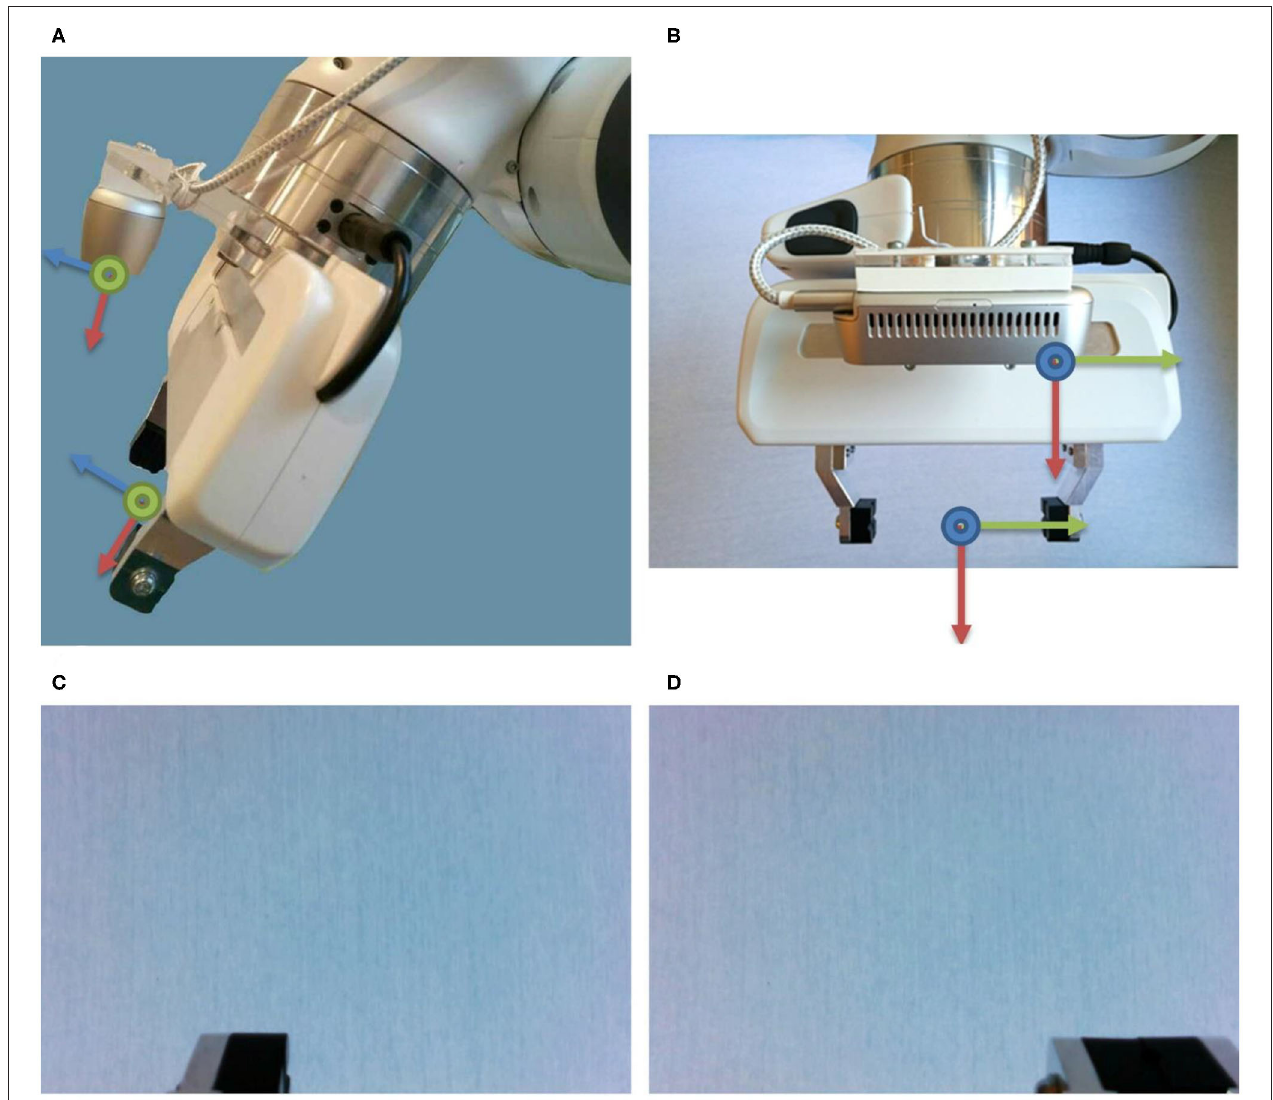
FIGURE 3 | The Intel Realsense D435 is mounted centrally, 2.56cm above the gripper, the Panda Hand, and (A) tilted by 16.7 ◦ . (B) The center of the RGB camera is shifted by 6.2cm in negative y-direction relative to the tool center point (TCP). The resulting RGB image that the subject sees with (C) open and (D) closed gripper. Thus, the last 2cm of the finger (only the left one when the hand is open, both when the hand is closed) can be